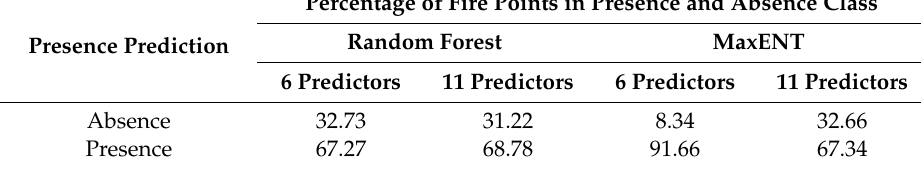
Table 6. Comparison of the di ff erent types of long-term wildfire presence prediction modeling methods in Nyurbinsky